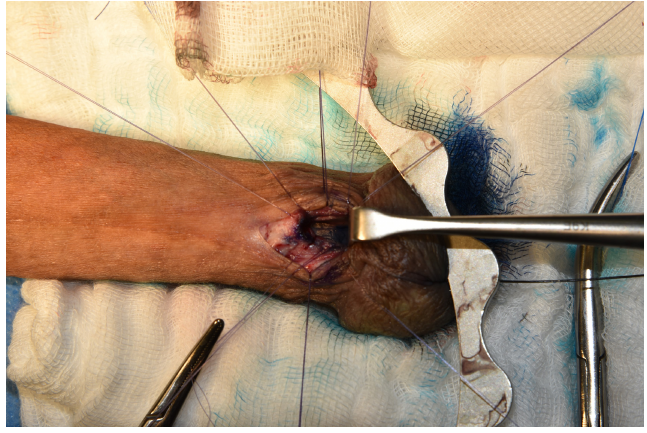
Figure 3. Overview of the keyhole incision with different traction sutures on the skin and ventral urethral mucosa. Through the opening, the healthy tissue can be clearly separated from diseased mucosa that colors with Methylene blue.